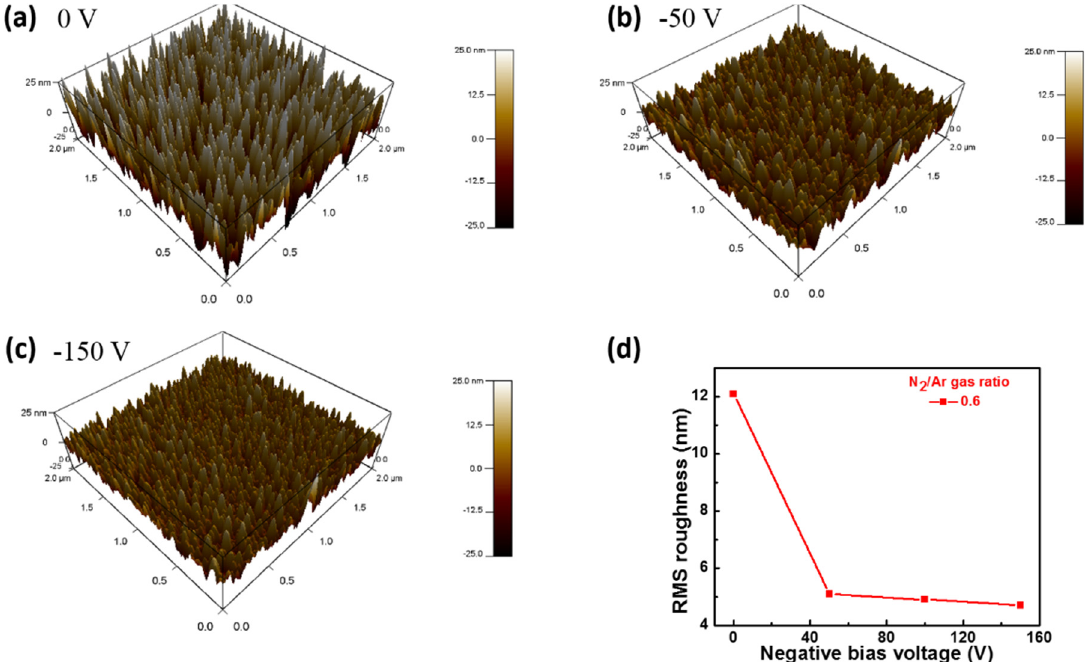
Figure 5. The three ‐ dimensional topographic AFM images of the typical NbN x >1 samples ( a – c ), and Root Mean Square (RMS) roughness deposited under different bias voltages with constant 0.6 ratio of N 2 /Ar ( d ).